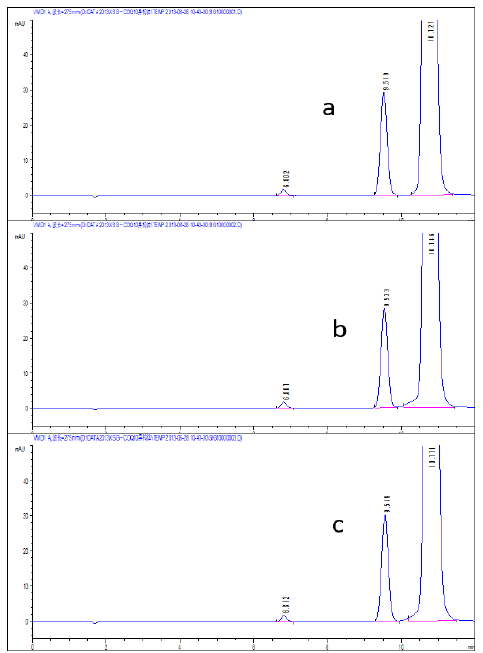
Figure 10. The system suitability spectrum obtained after 4 h at di ff erent concentrations of 30% hydrogen peroxide ( a 2 µ L; b 5 µ L; c 10 µ